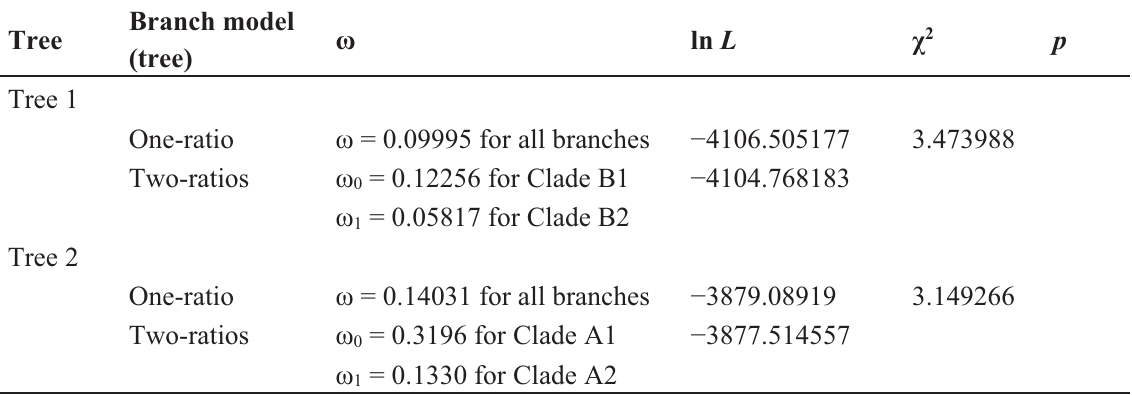
Figure 3. Phylogenetic trees of six orthologous 4CL genes between four poplar species and Arabidopsis for molecular evolution analyses. The trees were reconstructed using NJ with 100 bootstrap replicates. Based on the orthologs belonging to Clade A or Clade B in Figure 2, A and B represent Clade A and Clade B, respectively, so the desert poplar clades ( P . pruinosa and P . euphratica ) were assigned to A1 or B1 and the other species were assigned to A2 or B2. Table 3. Summary statistics of orthologs for detecting selection using branch models in